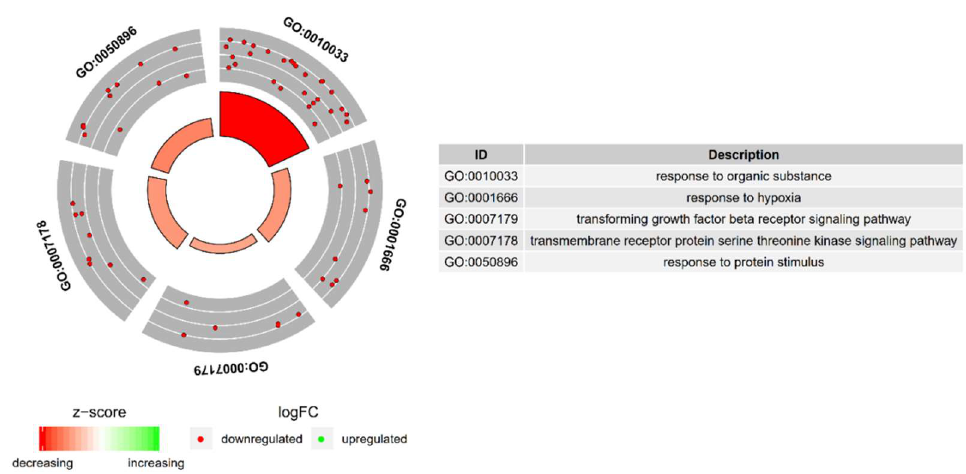
Figure 2. The circle plot showing the differently expressed genes and z-scores of the response to hypoxia, “response to organic substance”, “response to protein stimulus”, the “transforming growth factor β receptor signaling pathway”, and “transmembrane receptor protein serine threonine kinase signaling pathway” GO BP terms. The outer circle shows a scatter plot for each term of the fold change of the assigned genes. Green circles display up-regulation and red ones down-regulation. The inner circle shows the z-score of each GO BP term. The width of each bar corresponds to the number of genes within GO BP term and the color corresponds to the z-score. Table 1. Gene symbols, fold changes in expression, corrected p values and LogFC of studied genes.